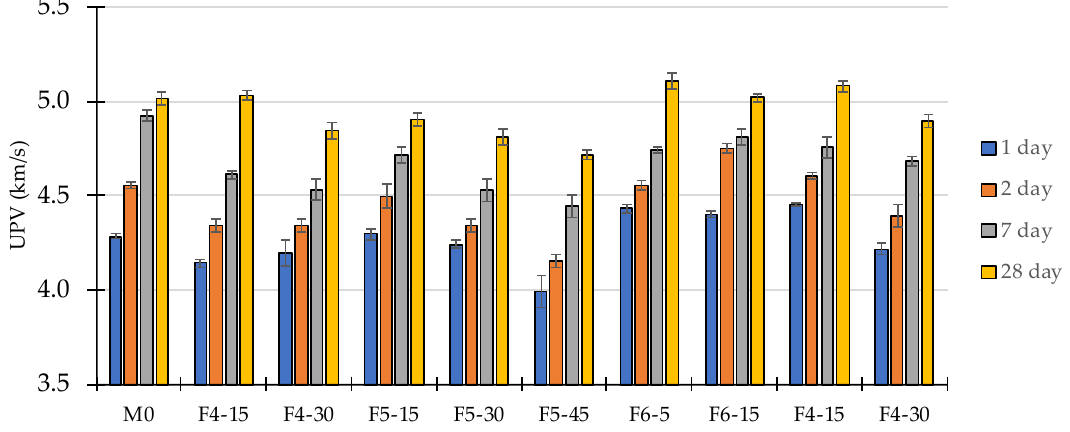
Figure 8. UPV measured on concrete specimens at 1, 2, 7 and 28 days of age .